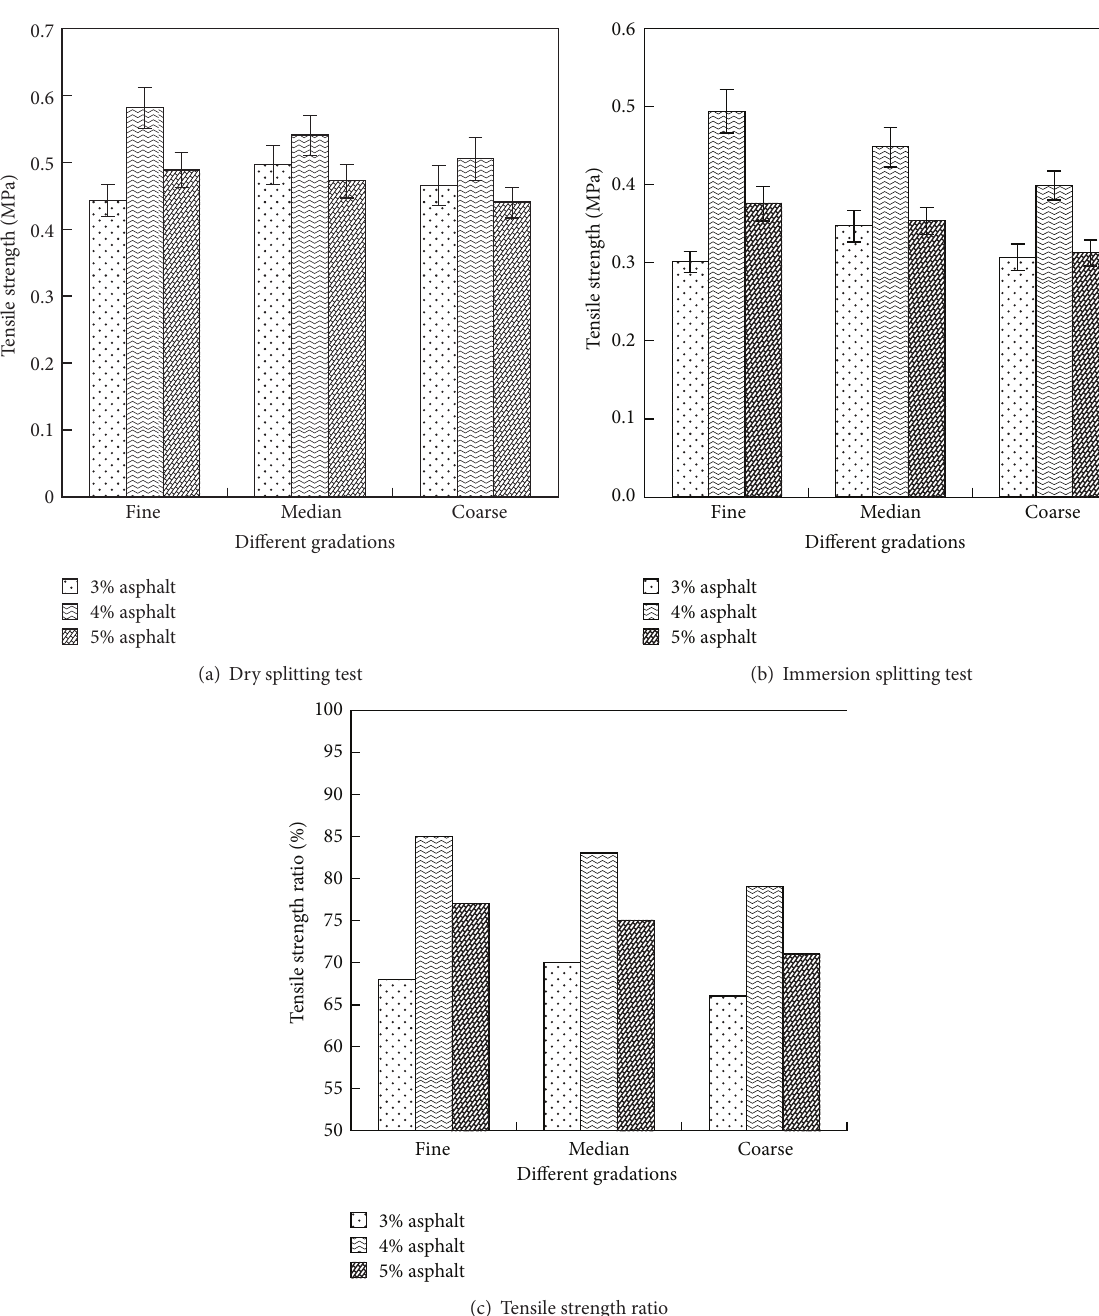
Figure 6: Tensile strength of cold recycled asphalt mixtures with emulsified asphalt